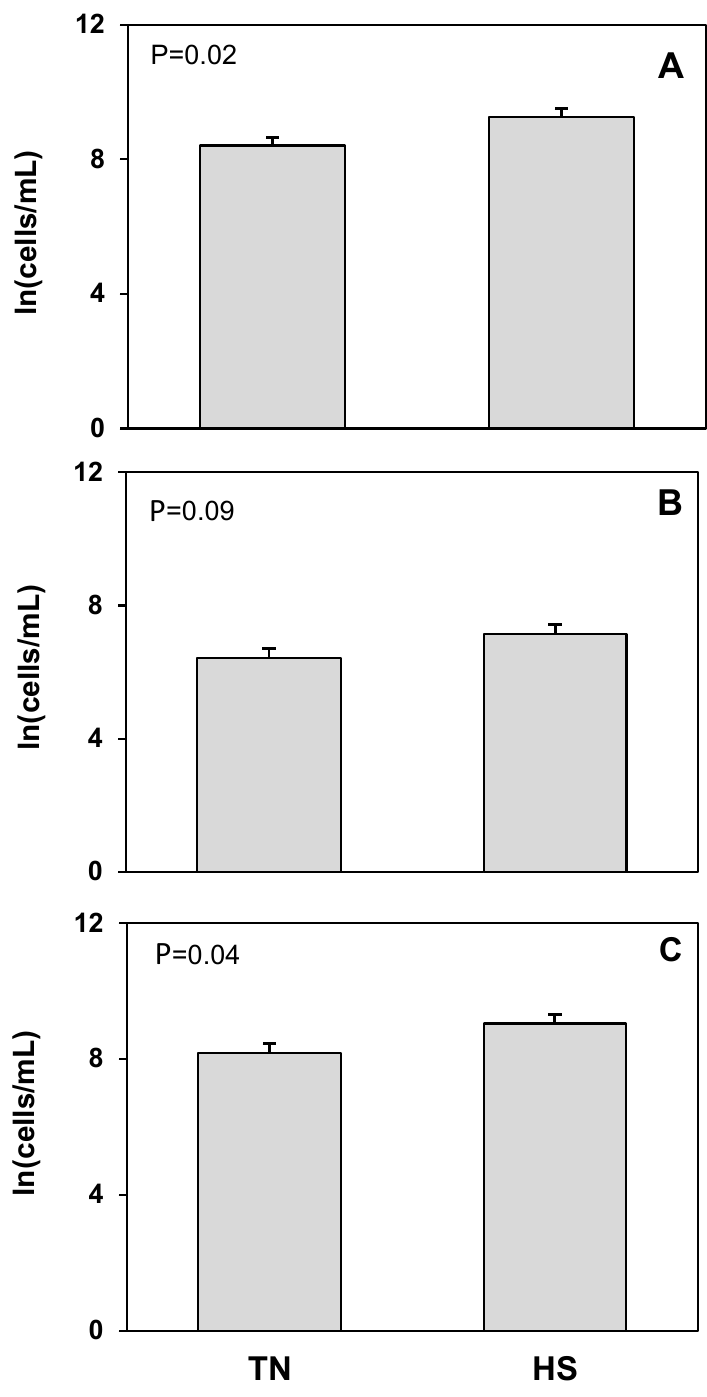
Figure 1. Heat stress (HS) impacts on mammary epithelial cells (butyrophilin positive; BTN + CD45 − ) cell concentration in milk compared to thermoneutral (TN) conditions. ( A ) Total cells, ( B ) live cells (propidium iodide negative; PI − ), and ( C ) dead cells (propidium iodide positive; PI + ). Cell population data were natural log transformed for statistical analysis. Values presented are least square means of natural log transformed data with error bars presenting the SEM (n = 10).